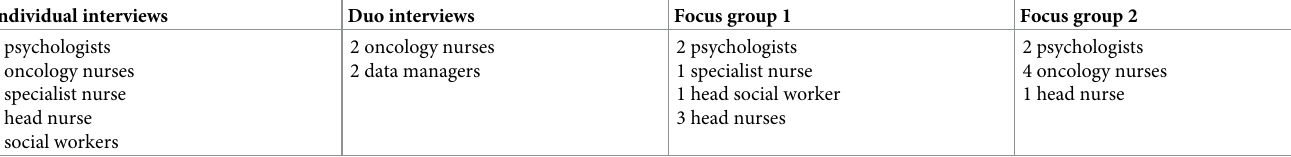
Table 1. Different non-physician care professions included per type of data collection.